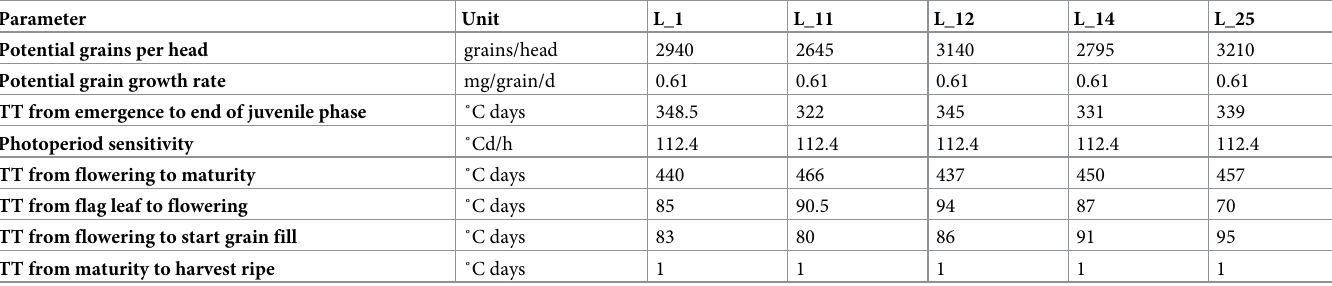
Table 1. Accession specific genotype coefficients used to calibrate APSIM